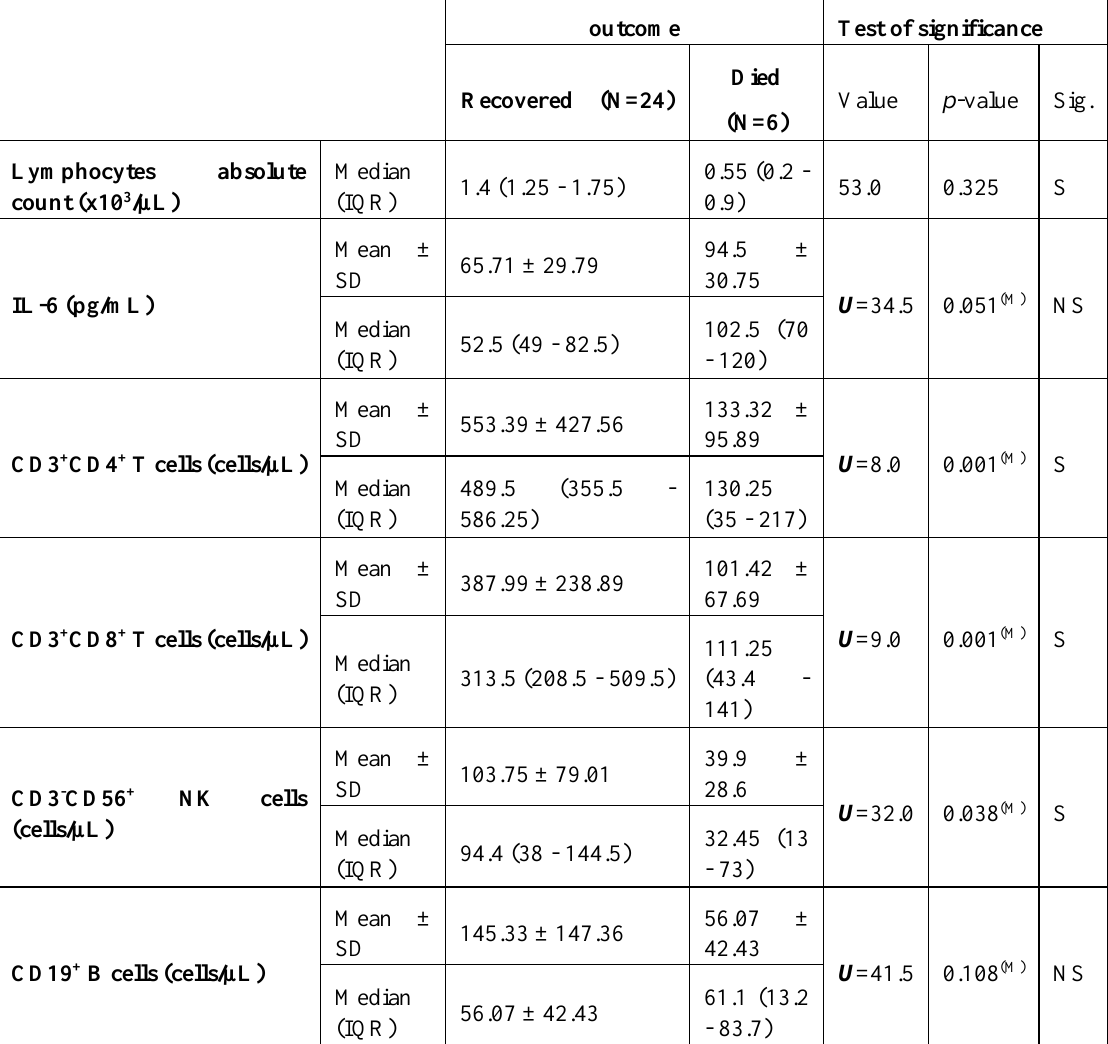
Table 3. Association of absolute lymphocytic count, IL-6 serum level and lymphocyte subset changes with outcome of COVID-19 patients.